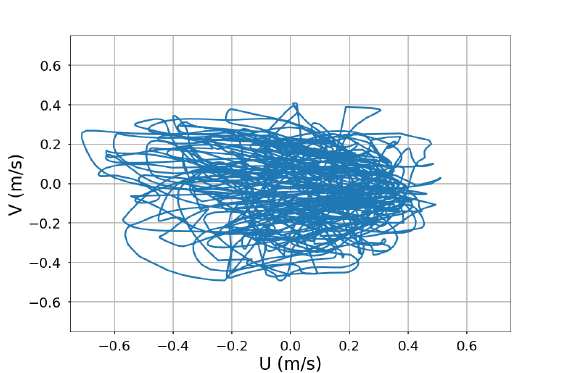
Figure 9. Time plot of the horizontal (U) versus the vertical (V) velocity components obtained from the ADCP located near the